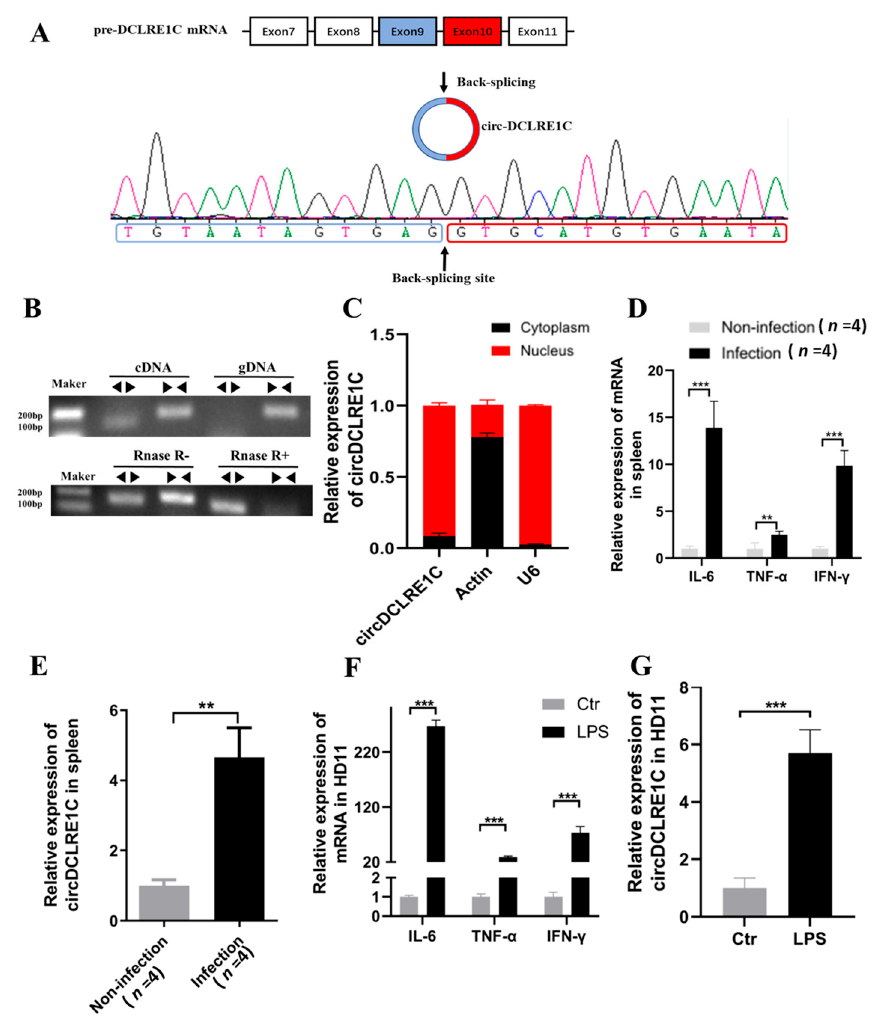
Figure 1. Characteristics of circDCLRE1C: ( A ) The schematic representation of circDCLRE1C’s formation. The back-spliced junction (BSJ) of circDCLRE1C was validated by PCR using a divergent primer, followed by Sanger sequencing. ( B , C ) Northern blot analysis for the detection of circDCLRE1C expression in HD11 cells treated with or without RNase R, respectively; divergent primers amplified circDCLRE1C from complementary DNA (cDNA), but not from genomic DNA (gDNA). ( D ) The relative expression levels of circDCLRE1C in the nucleus and cytoplasm were detected by qRT-PCR. ( E , F ) The expression of cytokines (IL-6, TNF- α , and IFN- γ ) and circDCLRE1C, respectively, in the spleens of non-infected and infected chickens, was detected by qRT-PCR; n = 4. ( G ) qRT-PCR analysis of the expression levels of cytokines (IL-6, TNF- α , and IFN- γ ) and circDCLRE1C, respectively, induced by LPS stimulation in HD11 cells. Data are presented as means ± SD ( n = 3 biologically independent samples). ** p < 0.01; *** p < 0.001 (Student’s t